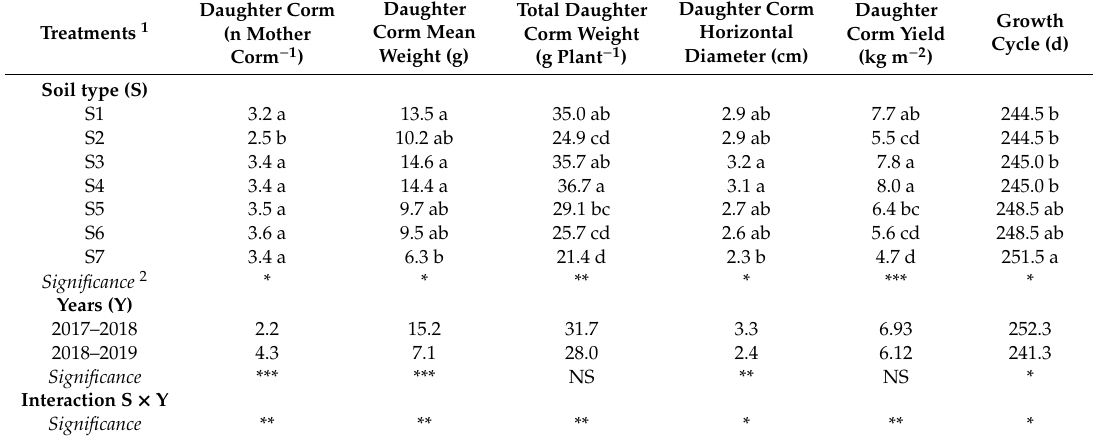
Table 6. E ff ects of the soil type on daughter corm traits and yield in two years.